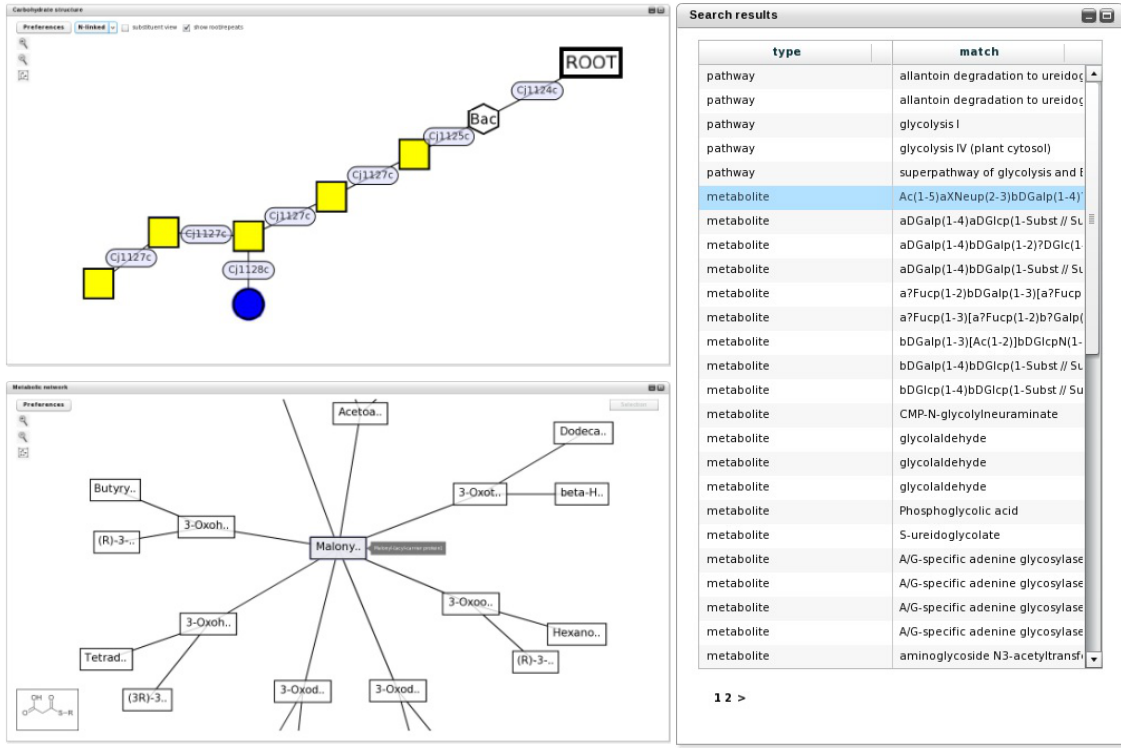
Figure 3 Glycan structure, metabolic network and search result